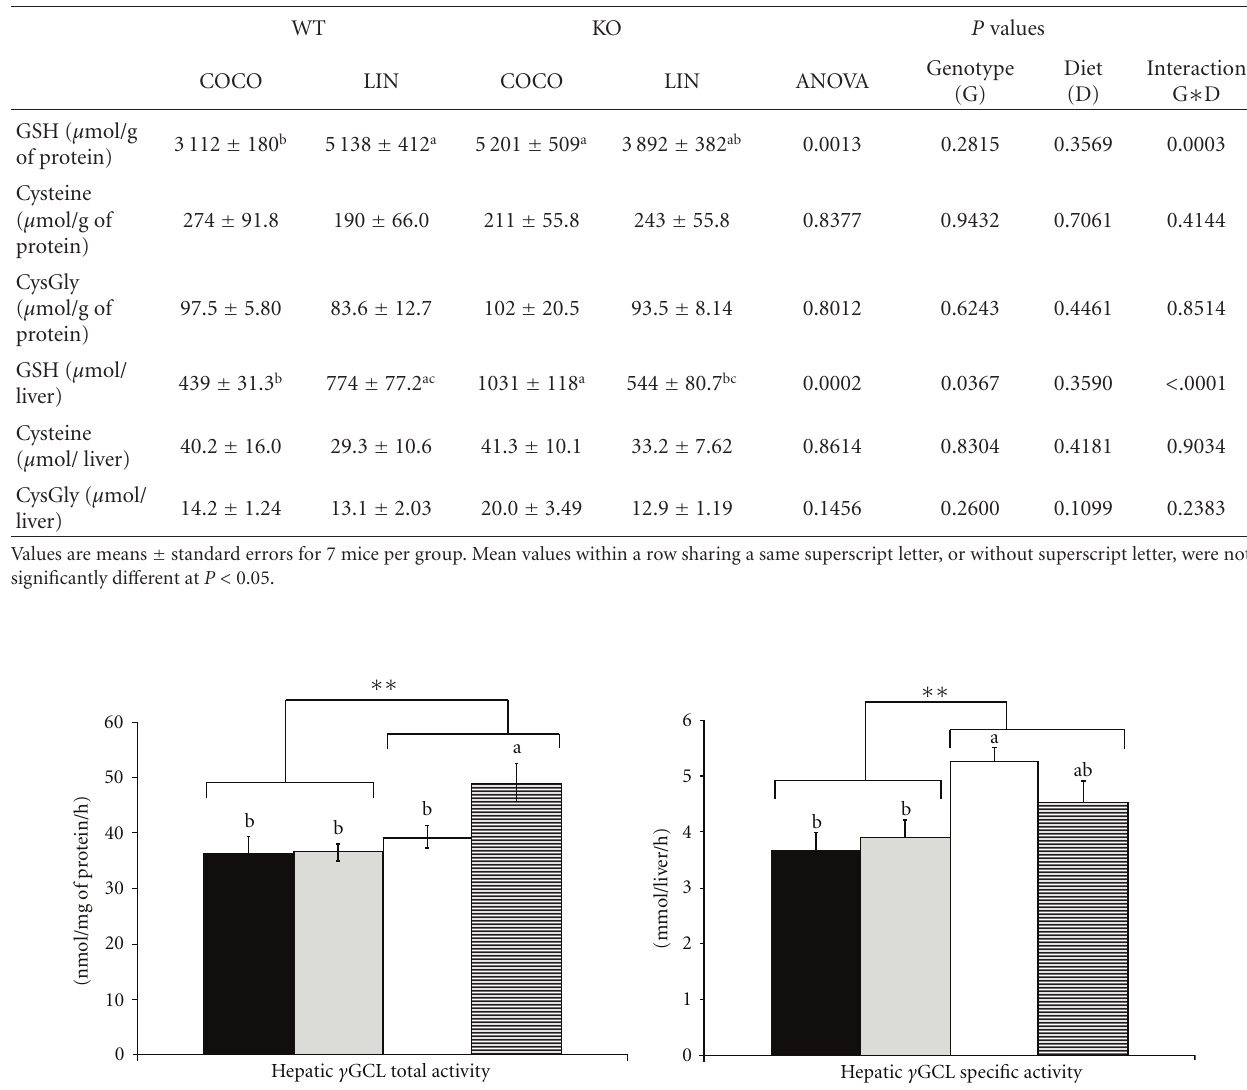
Table 3: Hepatic thiols concentrations and pools in WT and PPAR α -null (KO) mice fed diets containing either saturated FA (COCO diet) or ALA (LIN diet) for 8 weeks.